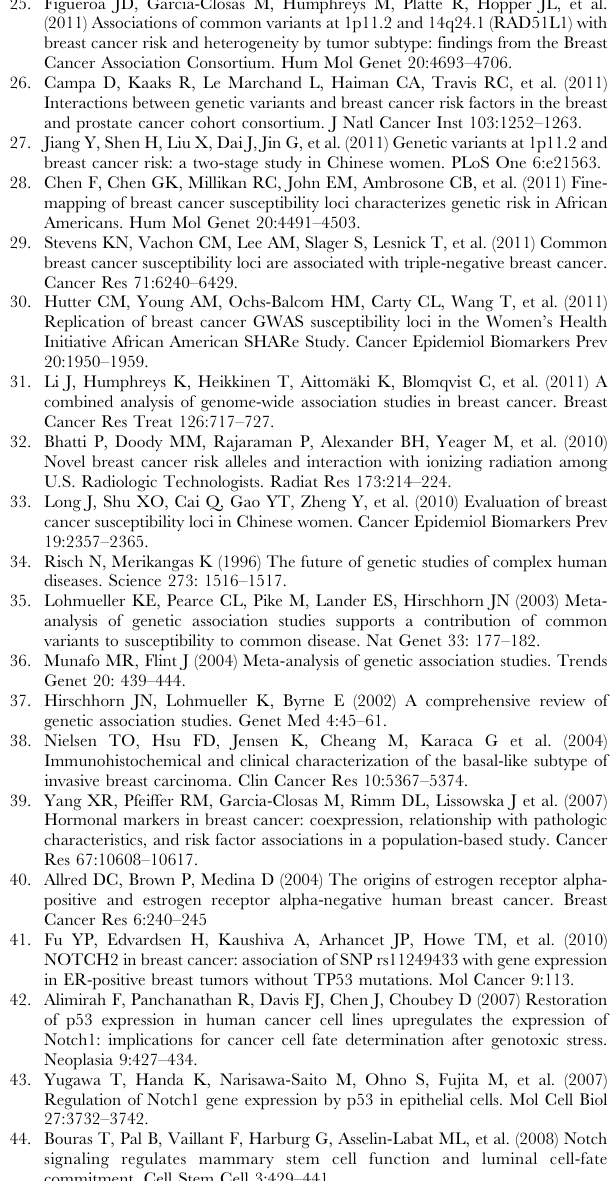
Figure S2 Begg’s funnel plot of 1p11-rs11249433 poly- morphism and BC risk. Figure S3 Test publication bias of studies of the 1p11- rs11249433 polymorphism of and BC using Egger